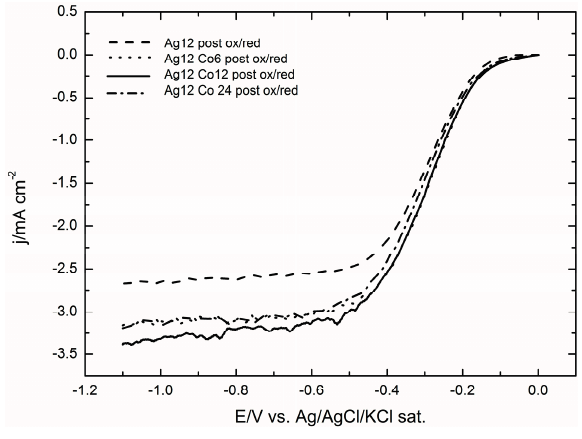
Figure 9. The effect of the oxidative/reductive treatment on the ORR of the GC/Ag of [31] and GC/AgCo samples recorded at 500 rpm and with a scan rate of 50 mV·s − 1